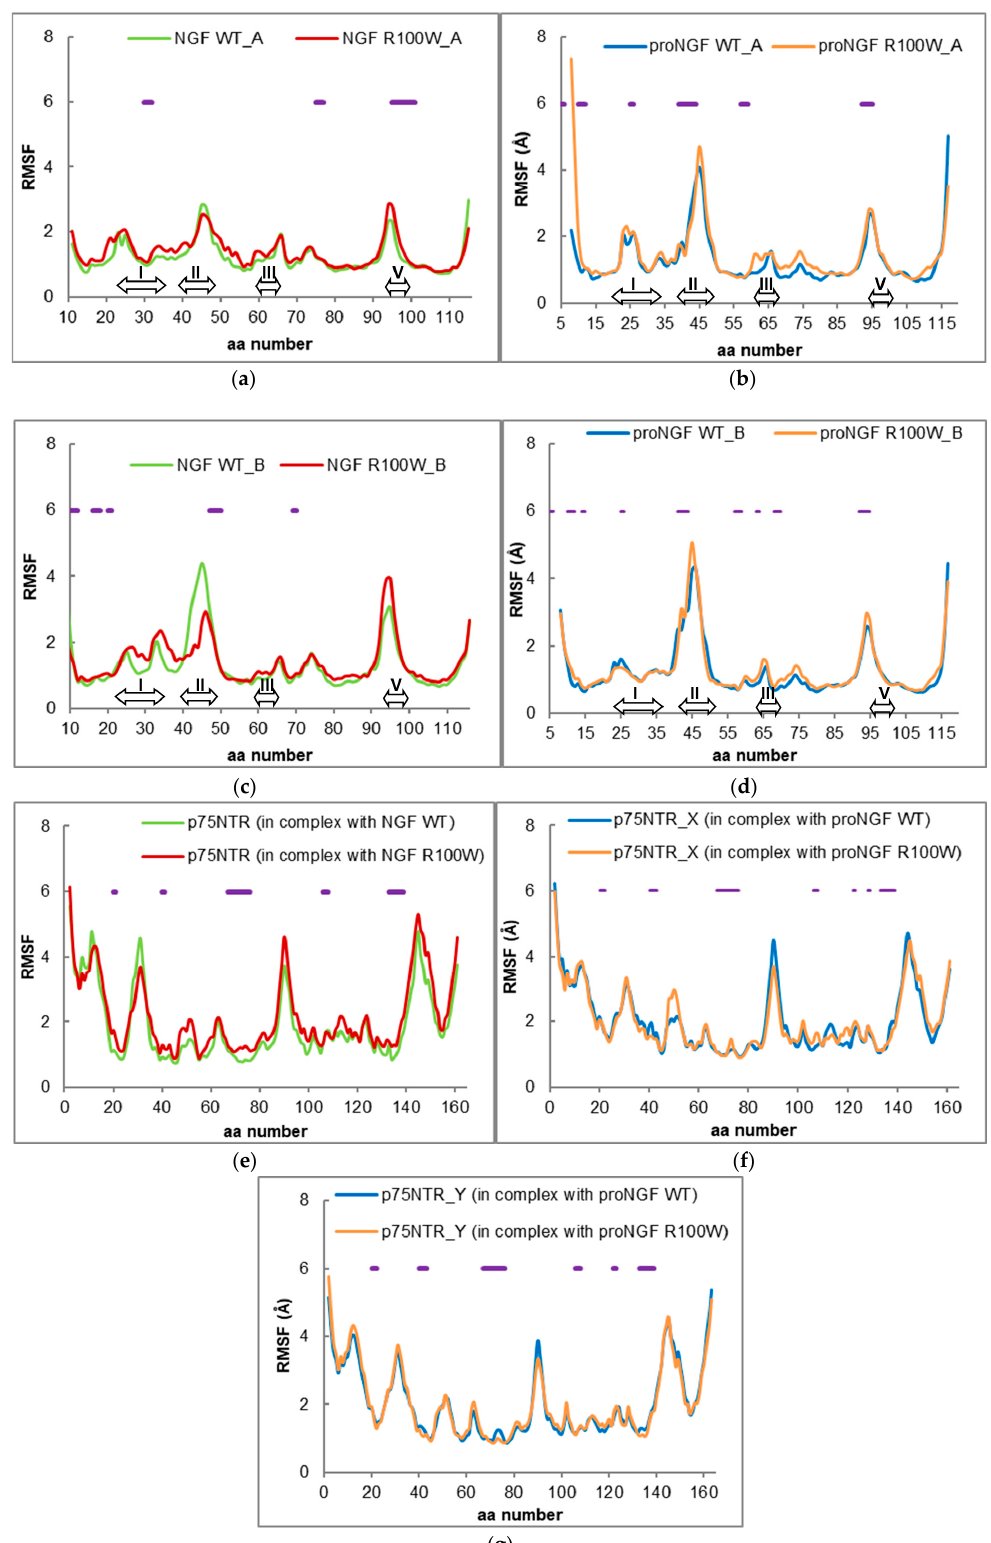
Figure 5. Plots of root-mean-square fluctuation of the backbone of the different chains composing both complexes: ( a ) NGF_A, ( b ) proNGF_A, ( c ) NGF_B, ( d ) proNGF_B, ( e ) p75NTR, ( f ) p75NTR_X, and ( g ) p75NTR_Y (the back arrows near the x axes map the NGF loops, according to [24]; the violet dots in the upper part below the legends highlight the contact interface residues). The highly flexible regions in both the proNGF WT and NGF WT complexes with p75NTR are mainly mapped at the level of the four loops and at the amino and carboxy termini. Loop V of the chain B of NGF in the p75NTR/NGF WT complex shows an in- creased RMSF with respect to that of chain A, as well as with respect to those of both the proNGF chains in the 2p75NTR/proNGF WT complex. Loop II is less flexible in the chain A of the p75NTR/NGF WT complex with respect to that of chain B, characterized by a